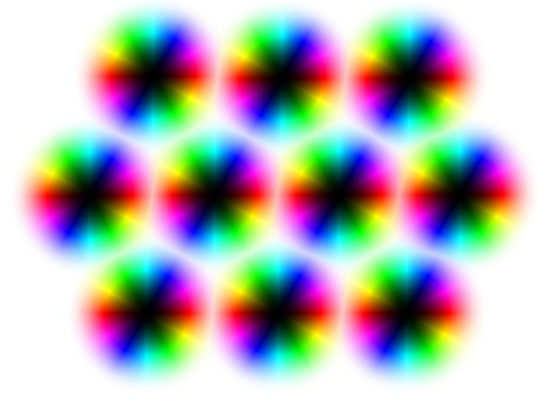
Figure 22 . A sketch of a possible lattice for nuclear matter in the baby-Skyrme model. Each con- stituent baby Skyrmion is placed such that the colors match between the latter and the neighboring baby